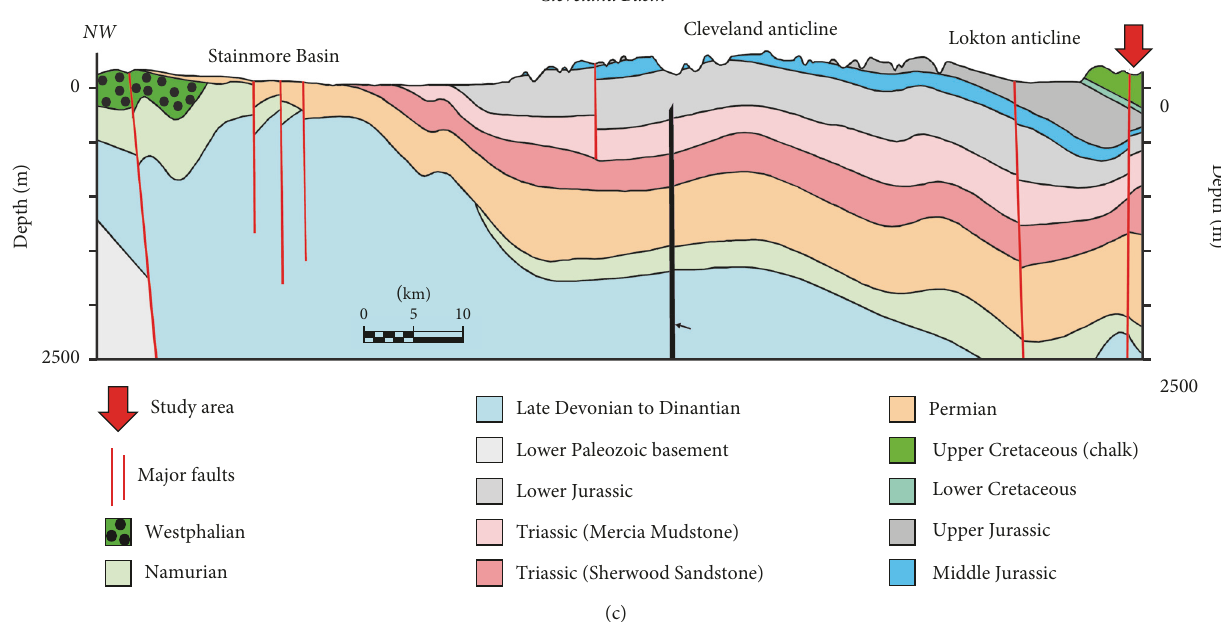
Figure 1: (a) Map of the Cleveland Basin, location of the study area and section (c). (b) Cleveland Basin lithology [12]. (c) Cross section of the Cleveland Basin (modified from BGS report